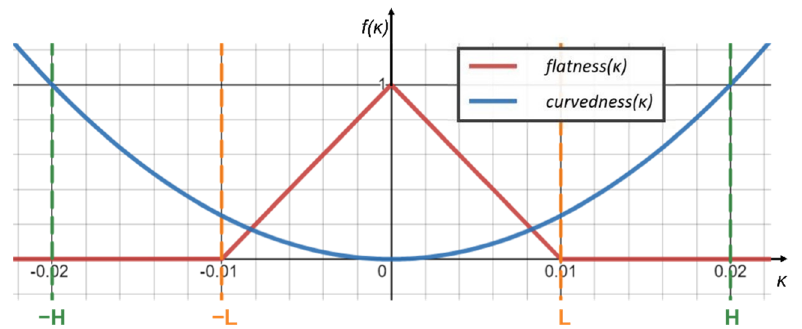
Figure 1. Curvature based functions to determine ‘flatness’ and ‘curvedness’ for a principal curvature ( L = 0.01, H = 0.02, see Equations (1) and (2)). Table 2. Calculation of curvature based geometric parameters.